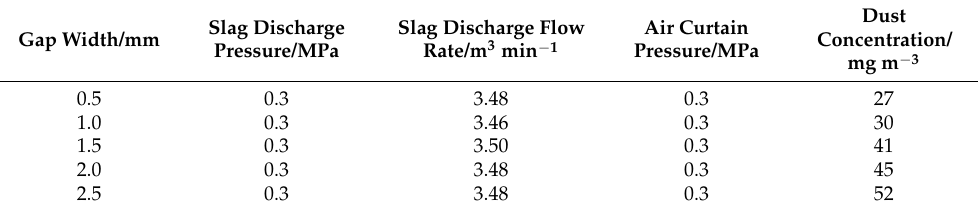
Table 1. The effect of gap width on dust